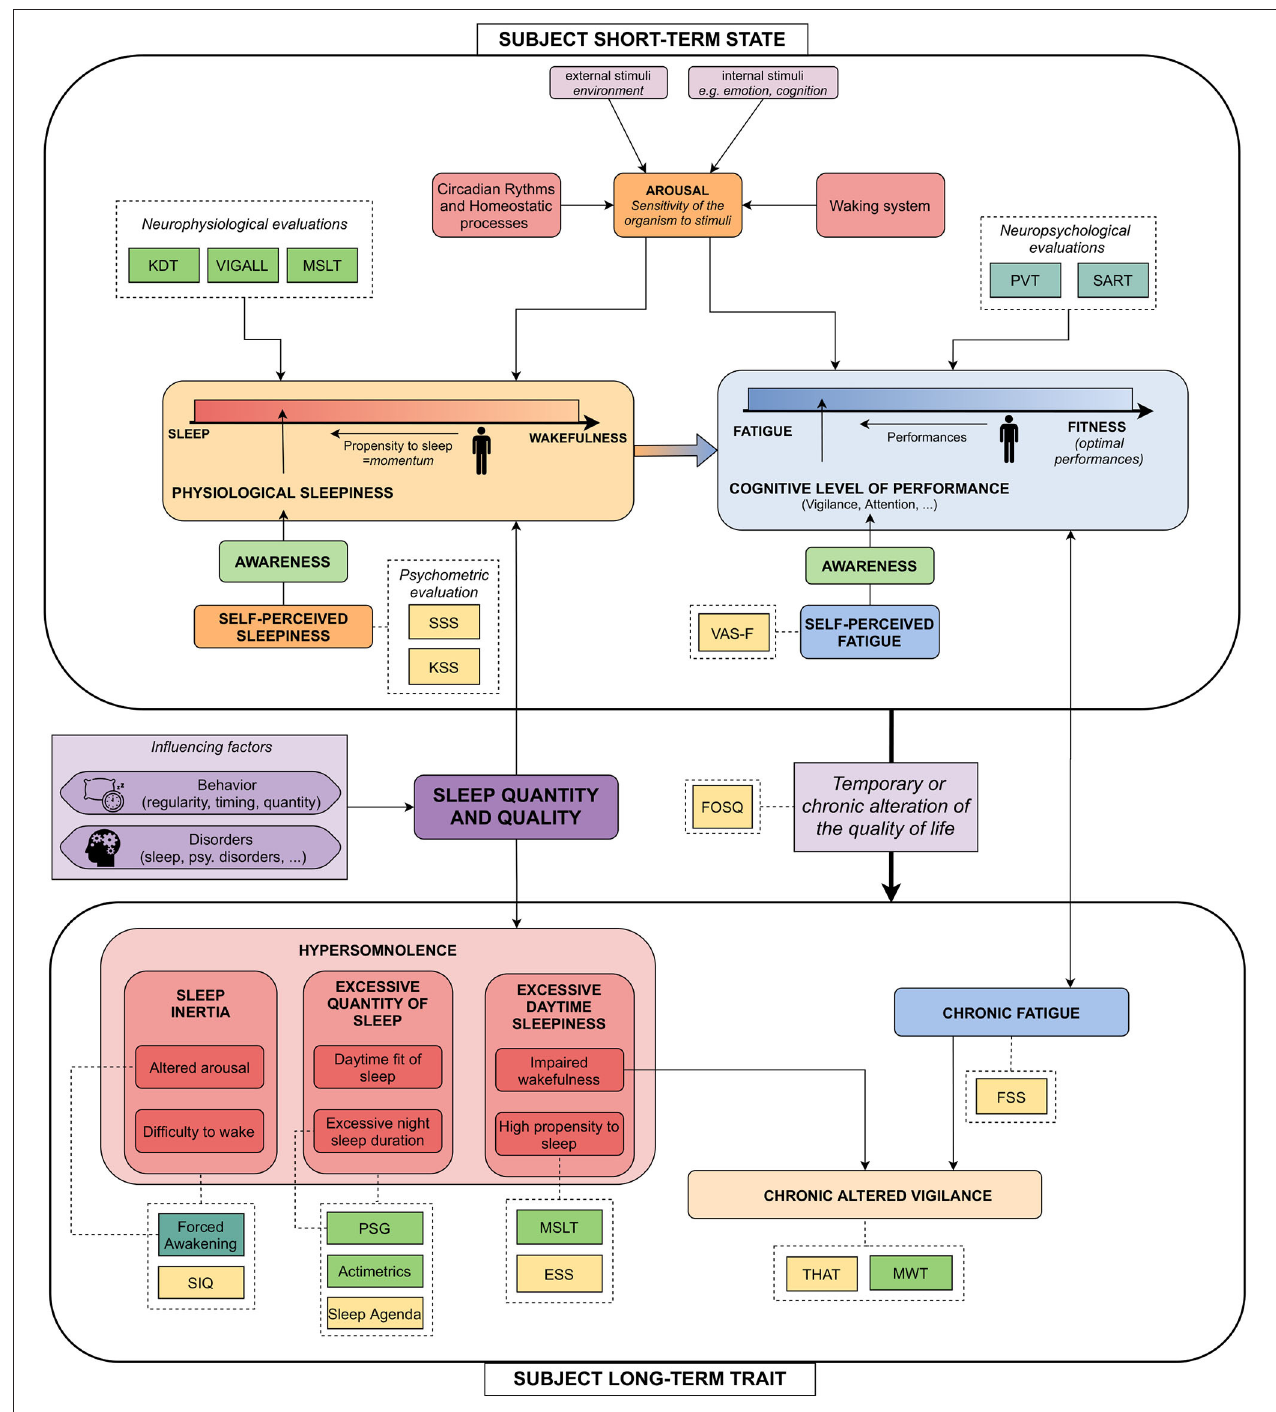
FIGURE 1 | Explicating figure highlighting the links between the commonly blended notions around sleepiness, and their measures. Light green dashed boxes: neurophysiological measures; Forest green dashed boxes: neuropsychological measures; Yellow dashed boxes: psychometric questionnaires. KDT, Karolinska Drowsiness Scale (32); VIGALL, Vigilance Algorithm Leipzig (33); MSLT, Multiple Sleep Latency Test (34); PVT, Psychomotor Vigilance Task (35); SART, Sustained Attention to Response Task (36); SSS, Stanford Sleepiness Scale (37), KSS: Karolinska Sleepiness Scale (32); VAS-F, Visual Analog Scale–Fatigue (38); SIQ, Sleep Inertia Questionnaire (39); Forced Awakening, Event-related potentials during forced awakening (40); PSG, Polysomnography; ESS, Epworth Sleepiness Scale (41); MWT, Maintenance of Wakefulness Test (42); THAT, Toronto Hospital Alertness Test (43); FSS, Fatigue Severity Scale (44); FOSQ, Functional Outcomes of Sleep Questionnaire